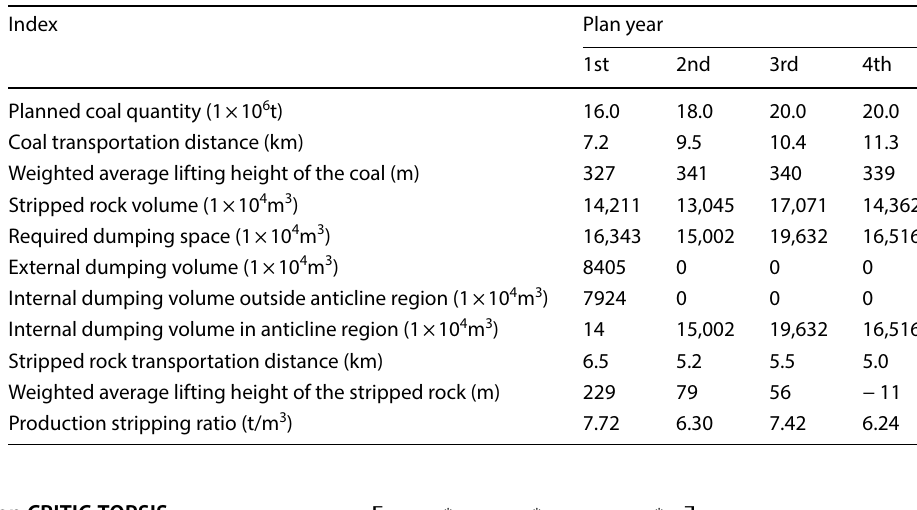
Table 7 Technical index summary of mining and dumping plan of pseudo- longitudinal mining